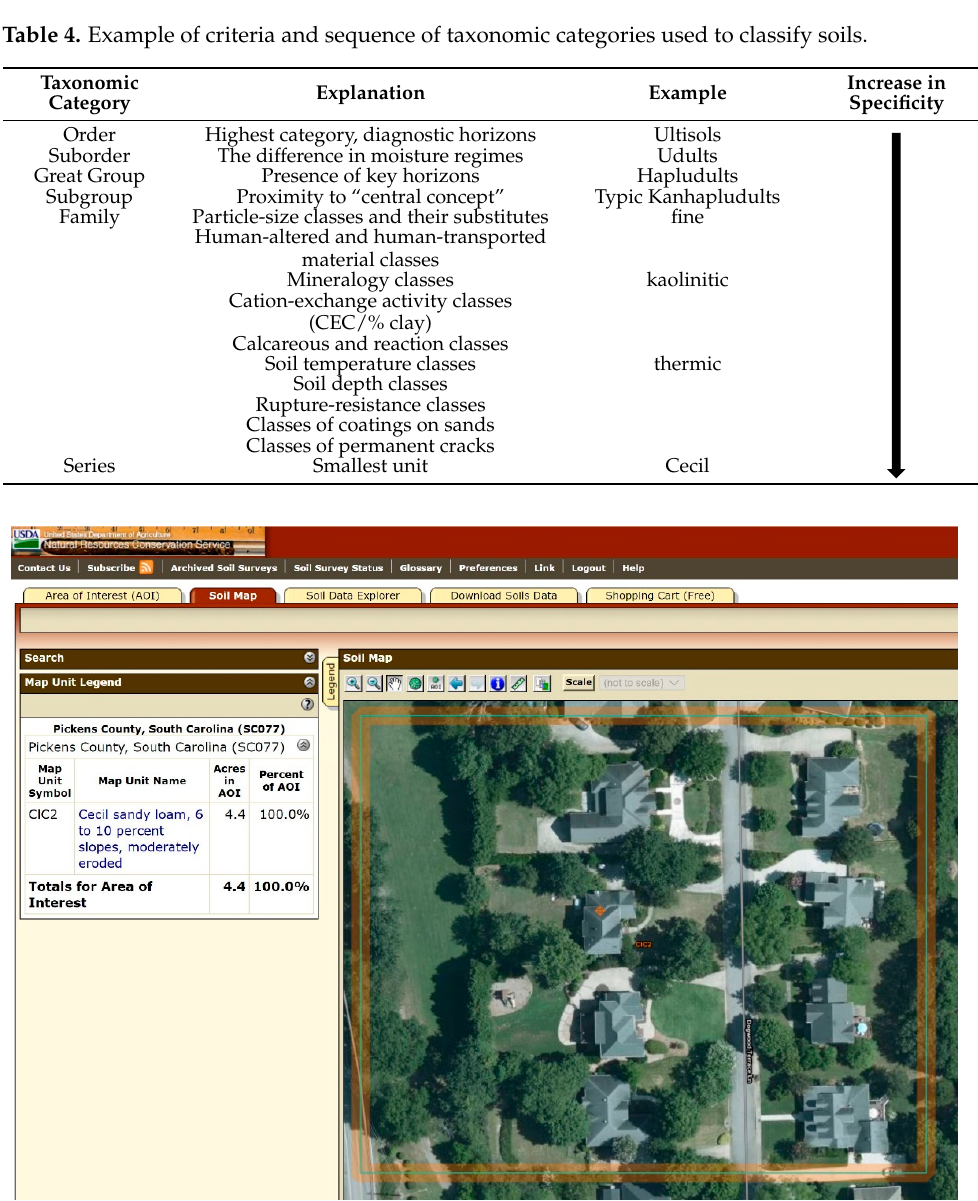
Figure 2. Example of a soil map generated with Web Soil Survey (WSS) [33] showing soil cover and land use. Table 5. Example of different soil properties (e.g., physical soil properties) in the Web Soil Survey (WSS) [33]. Map Symbol and Soil Name